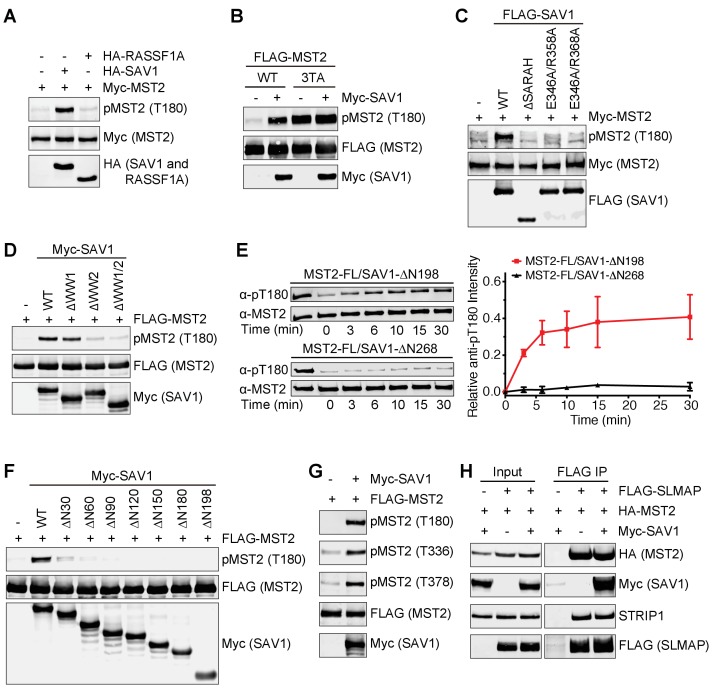
All discernable domains of SAV1 are required for MST2 activation.(A) Immunoblots of lysates of 293FT cells co-transfected with the indicated Myc-MST2 and HA-SAV1 or HA-RASSF1A plasmids. (B) Immunoblots of lysates of 293FT cells co-transfected with Myc-SAV1 and the indicated FLAG-MST2 plasmids. (C) Immunoblots of lysates of 293FT cells co-transfected with Myc-MST2 and the indicated FLAG-SAV1 plasmids. (D) Immunoblots of cell lysates of 293FT cells co-transfected with FLAG-MST2 and the indicated Myc-SAV1 plasmids. (E) Total MST2 and pT180 blots of the auto-kinase reactions by the indicated MST2-SAV1 complexes at the indicated time points (left panel). The kinetic profiles of T180 autophosphorylation of MST2-FL/SAV1-∆N198 (red line) and MST2-FL/SAV1-∆N268 (black line) are shown on the right. The relative anti-pT180 intensities were normalized against MST2-FL without PP2A phosphatase treatment (100%). Data are representative of at least two independent experiments. (F) Immunoblots of lysates of 293FT cells co-transfected with FLAG-MST2 and the indicated N-terminal truncation of Myc-SAV1 constructs. (G) 293FT cells were co-transfected with FLAG-MST2 and Myc-SAV1 plasmids. The total cell lysates were blotted with the indicated antibodies. (H) 293FT cells were co-transfected with the indicated plasmids encoding FLAG-SLMAP, HA-MST2 and Myc-SAV1. Anti-FLAG IP and the total cell lysates (input) were blotted with the indicated antibodies.